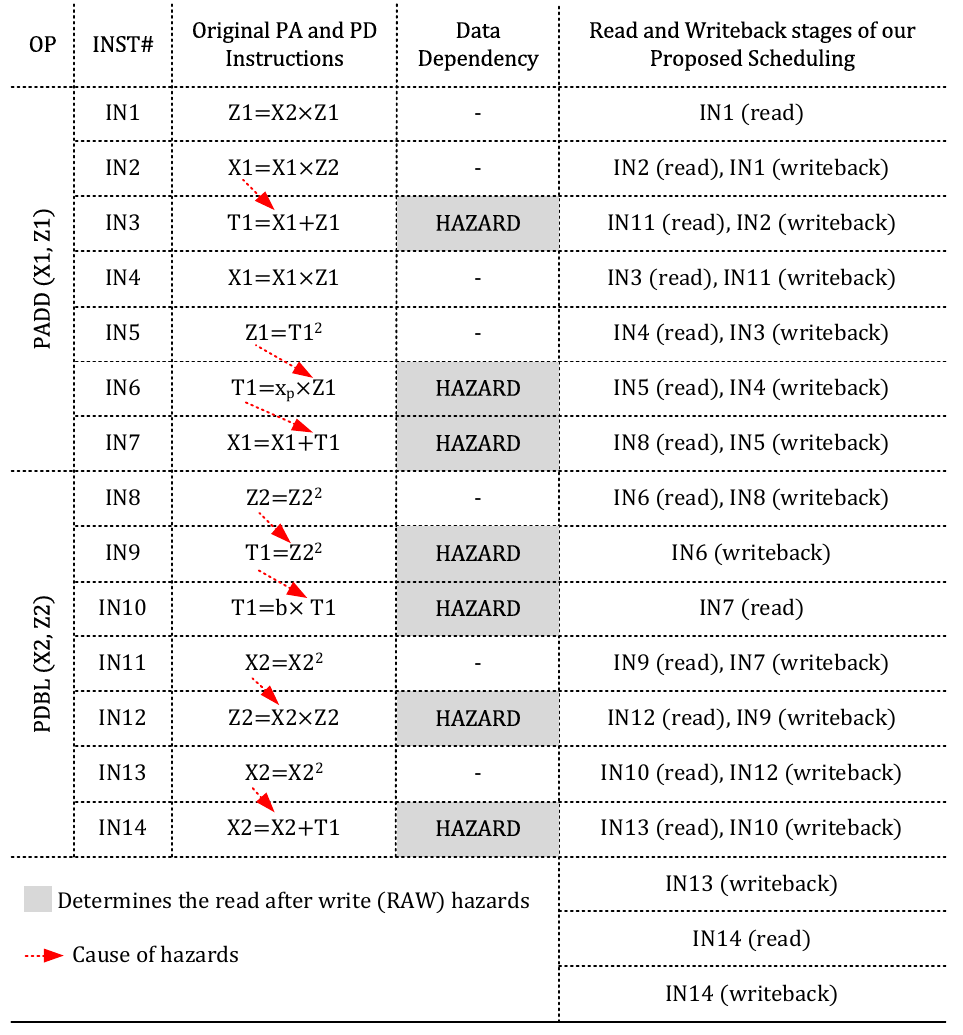
Figure 2. Proposed scheduling of PADD and PDBL functions (from Algorithm 1) for the computation of PM operation in